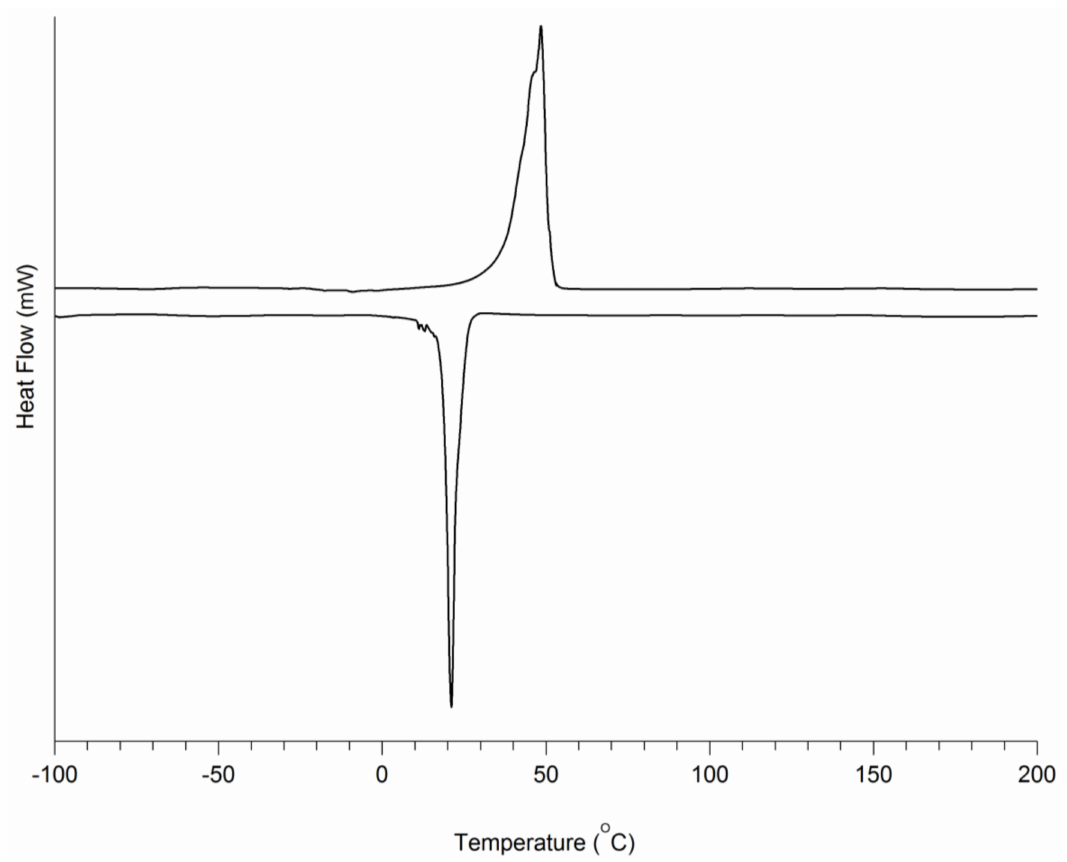
Figure 5. DSC thermogram of TPU-(PCL 5 -PEG 10 -PCL 5 ) in the dry state. The sample was heated from − 100 ◦ C to 200 ◦ C at 10/min, then cooled at a rate of 10/min. Table 3. Thermal characteristics of TPU-(PCL- b -PEG- b -PCL) in the dry and in the wet state. Water Uptake (wt.%) Tg ( ◦ C) Tc ( ◦ C) Tm ( ◦ C) ∆ H (J/g) TPU-(PCL 3 -PEG 14 -PCL 3 DRY